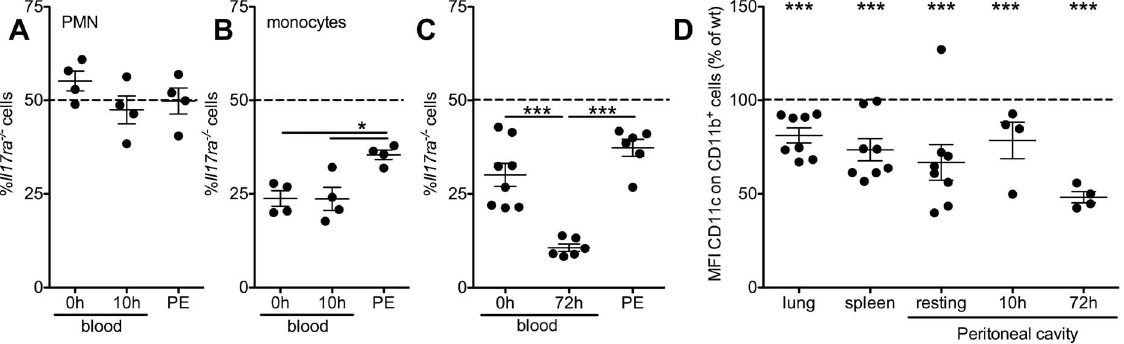
Figure 8. In peritonitis, Il17ra -/- monocyte recruitment is sustained, but macrophage phenotype changed. ( A,B ) Peritonitis was induced in mixed bone marrow chimeric wt/ Il17ra -/- mice. Peripheral blood (at start and end of the experiment) and peritoneal neutrophils (PMN, CD11b + CD115 2 Gr1 high , A) and monocytes (CD11b + CD115 + , B) were analyzed by flow cytometry after 10 h (n=4, Bonferroni after ANOVA). ( C ) At day 3, intraperitoneal myeloid CD11b + cells were analyzed and compared to peripheral blood monocytes at start and end of the experiment (n=4–6, 2 independent transplantations, Bonferroni after ANOVA). ( D ) CD11c expression on wt and Il17ra -/- myeloid (CD11b + ) cells was compared in lung, spleen, resting and inflamed peritoneal cavity of mixed bone marrow chimeric wt/ Il17ra -/- mice (n=4–8, paired t-tests).